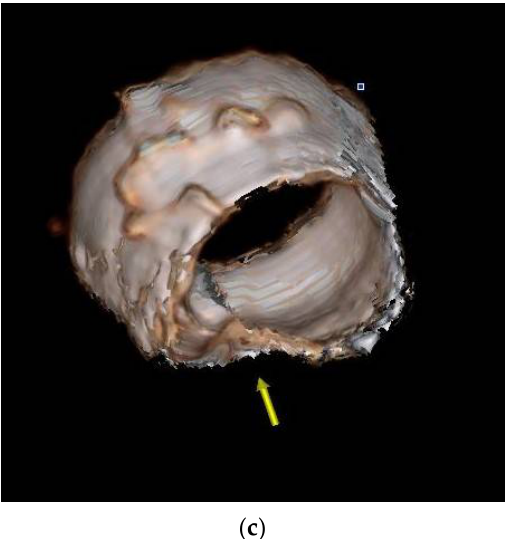
Figure 4. Oblique MPR ( a ), axial ( b ) and 3D anatomical model ( c ) of transcatheter PHV (LOTUS Edge 27 mm) focusing on its frame’s partial crumpling (arrow). A cluster of calcifications can be noted under the PHV.